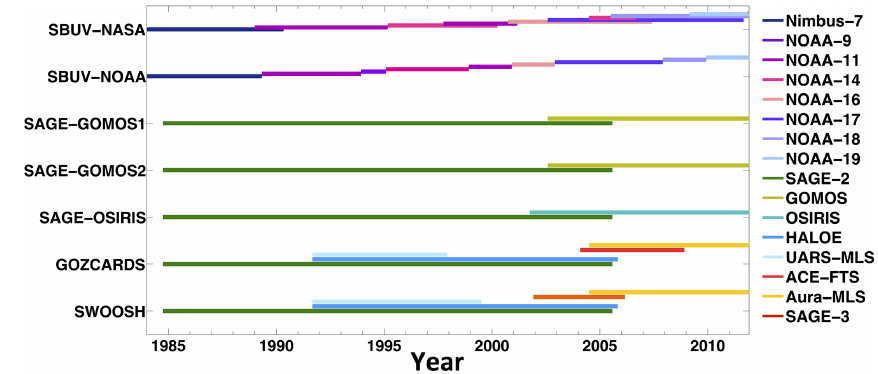
Figure 1. Time coverage of the individual instruments used in each of the seven data sets considered in this study for the 1984–2011 period.